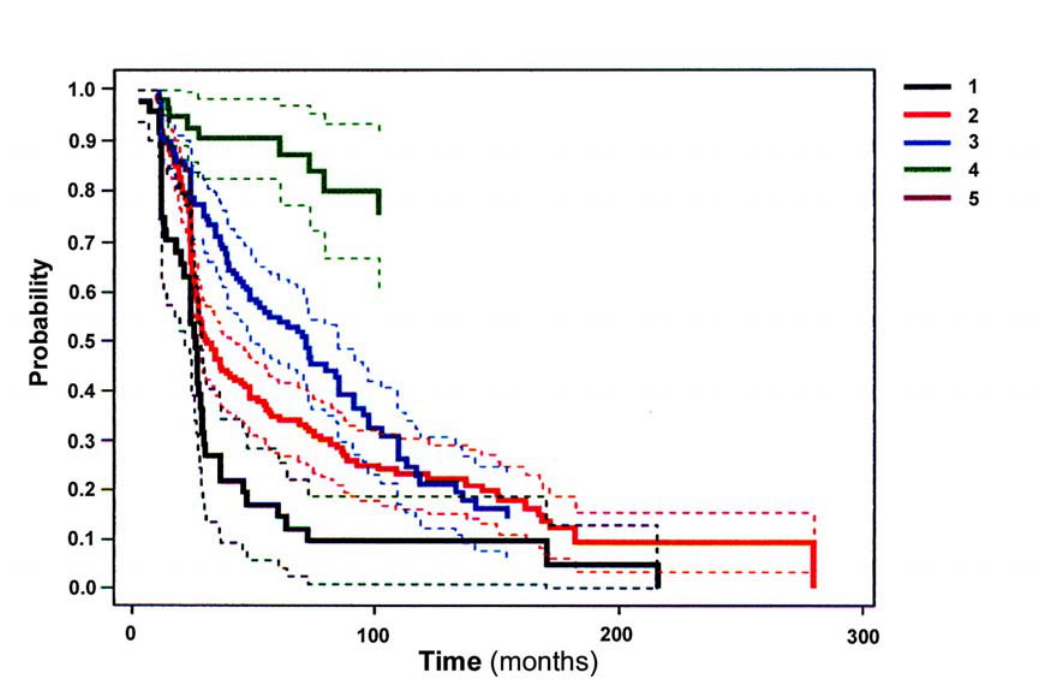
Figure 3 – Kaplan-Meier survival curves with 95% of confidence interval showing the probability of vesicoureteral reflux resolution, in months, according to